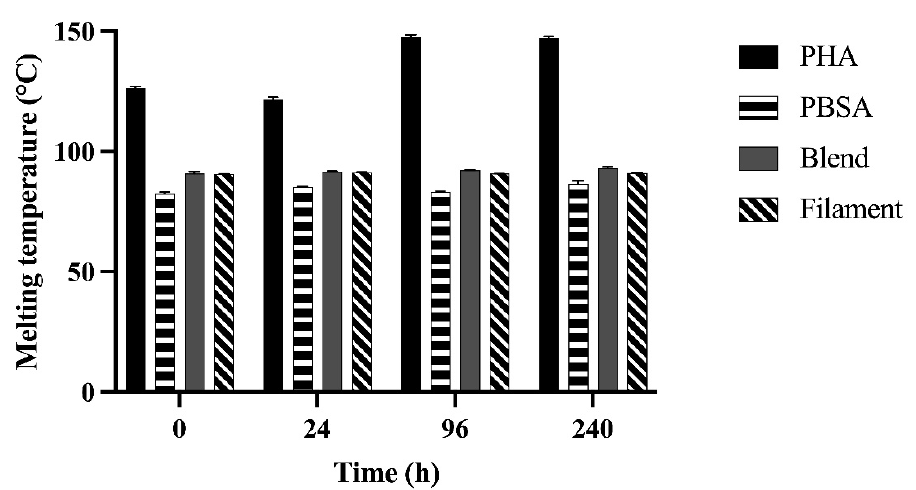
Figure 3. Melting temperature of PHA, PBSA, Blend, and Filament treatments after fermentation in rumen fluid for 0, 24, 96, and 240 h in F57 bags. Melting temperature (°C) of the treatments was determined from the first endothermic peak in the first heating scan. When comparing nurdles, Treatment: p < 0.01, Time: p < 0.01, Treatment × Time: p < 0.01. When comparing Blend and Filament treatments, Treatment: p = 0.01, Time: p = 0.05, Treatment × Time: p = 0.23.